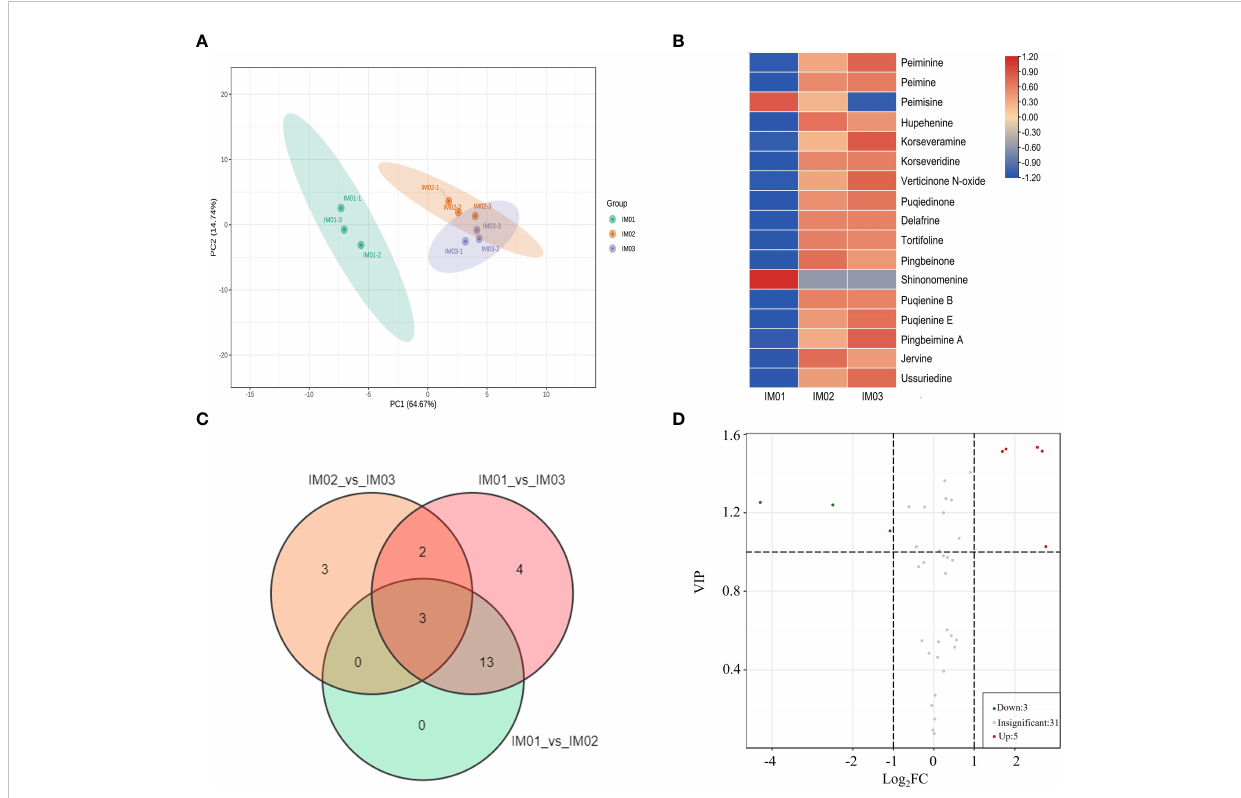
FIGURE 3 Metabolite analysis in regenerated bulbs of F. hupehensis . (A) . PCA of metabolomic data. (B) . Heatmap of DEAs. (C) . Venn diagram of DEAs between the three compared groups: “ IM01_vs_IM02 ” , “ IM01_vs_IM03 ” , and “ IM02_vs_IM03 ” . (D) . Volcano plots of DEAs in the comparison group of “ IM02_vs_IM03 ”